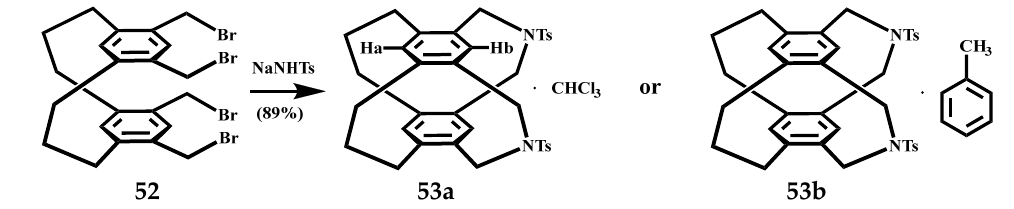
Figure 23. Synthesis of a new quadruple bridged cyclophane 53 .